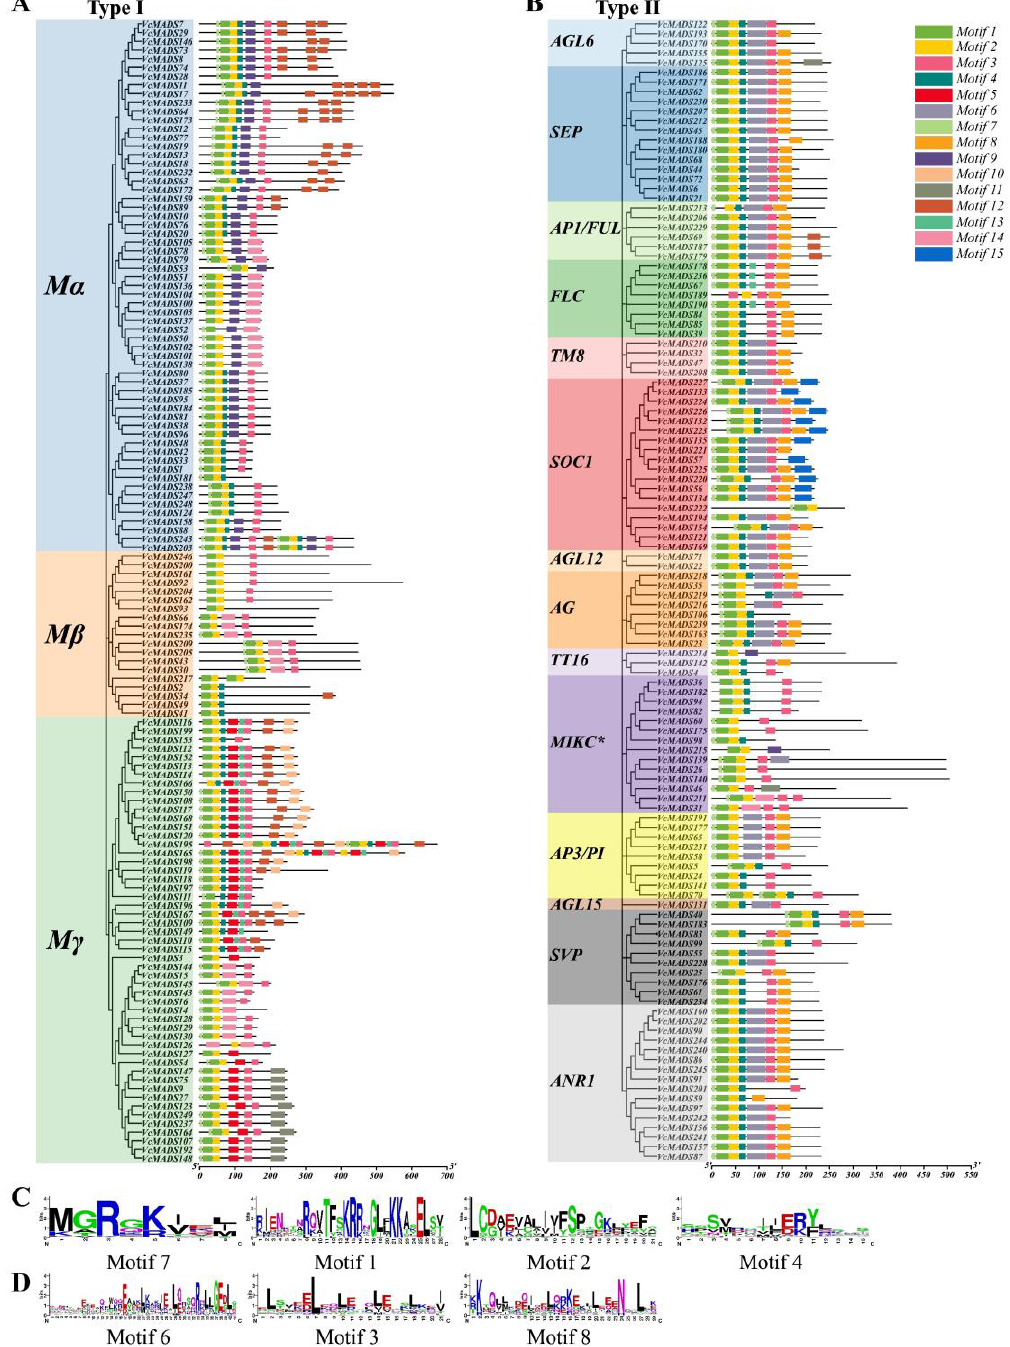
Figure 5. Conserved motif analysis of 249 VcMADS proteins. ( A , B ) Conserved motifs of type I and type II MADS-box proteins, respectively. ( C ) The 4 motifs located in the MADS domain region. ( D ) The 3 motifs found in the K-box domain region. ( D ) The 3 motifs found in the K-box domain